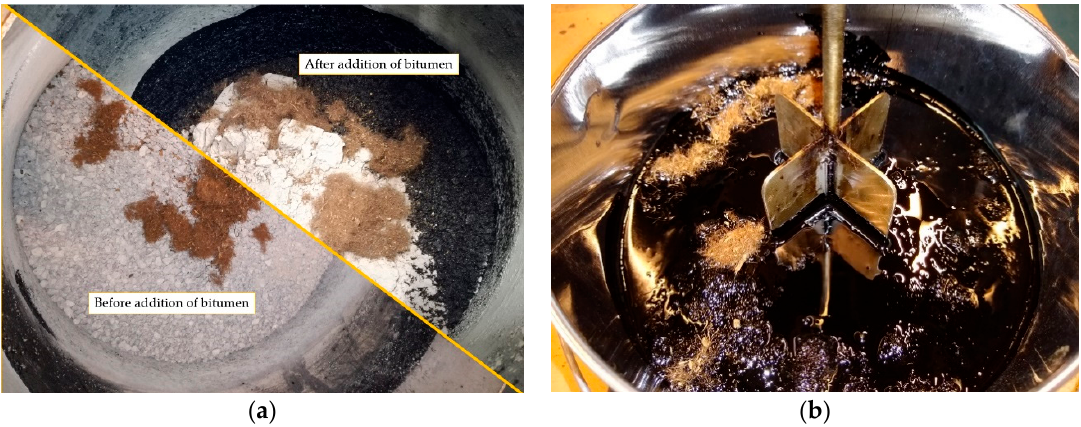
Figure 14. The drainage test: ( a ) asphalt mixes with peat and ( b ) the REF asphalt mix [24]. Figure 15. Mixing of peat fibers in the asphalt mix: ( a ) the first approach and ( b ) the second approach.